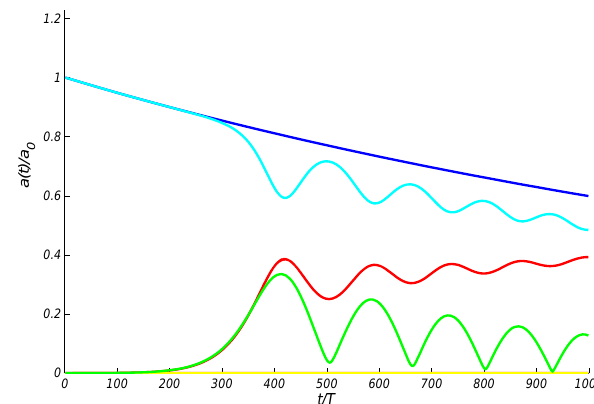
Fig. 2. Time evolution of the normalized amplitudes of the fundamental mode ( k = 5), subharmonic mode ( k = 4) and superharmonic mode ( k = 6) for ( A ,(cid:127)) = ( 4 , 0 . 61 ) . Fundamental mode amplitude ( — ), subharmonic mode amplitude ( — ) and superharmonic mode amplitude ( — ) for an initially unperturbed Stokes’ wave (unseeded case). Fundamental mode